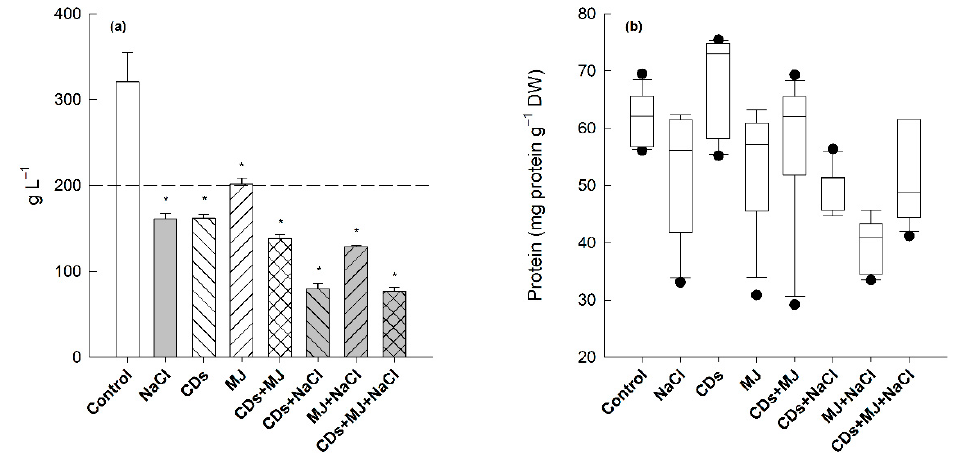
Figure 1. The effects of salt and/or elicitor treatments on ( a ) cell biomass accumulation (g L − 1 ) and ( b ) total protein content in Monastrell suspension cultured cells (SCC) (mg protein g − 1 FW). 15-day-old suspension cell cultures were maintained for 4 d without elicitors (control) or supplemented with a single, double, or triple combination of NaCl (50 mM), CDs (50 mM), and methyl jasmonate (MJ) (0.1 µ M). Data represent the mean ± SE of three independent experiments. Treatments marked with an asterisk are significantly different from the control ( p < 0.05) by Tukey’s honestly significant difference (HSD) test. Protein values are expressed as box-and-whisker plots. The box represents the interquartile range (IQR), the bold line in box represents the median, the whiskers represent 1.5 times the IQR, and the single dots (•) represent outlier points.